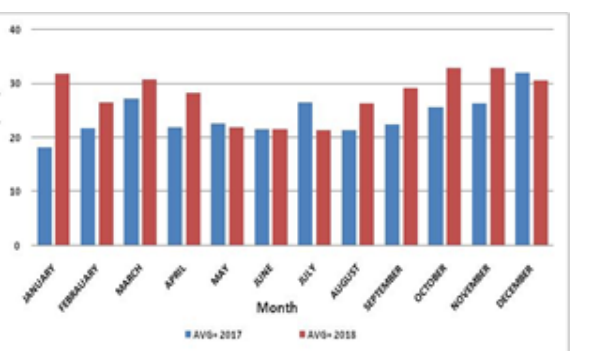
Figure 27. Comparison between RCIs for the average values of upward power ramps in 15 min interval for each month for years 2017 and 2018.